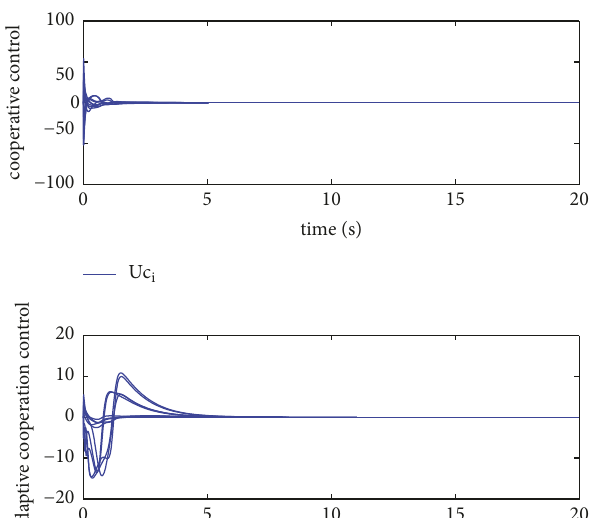
Figure 3: Cooperative control input.